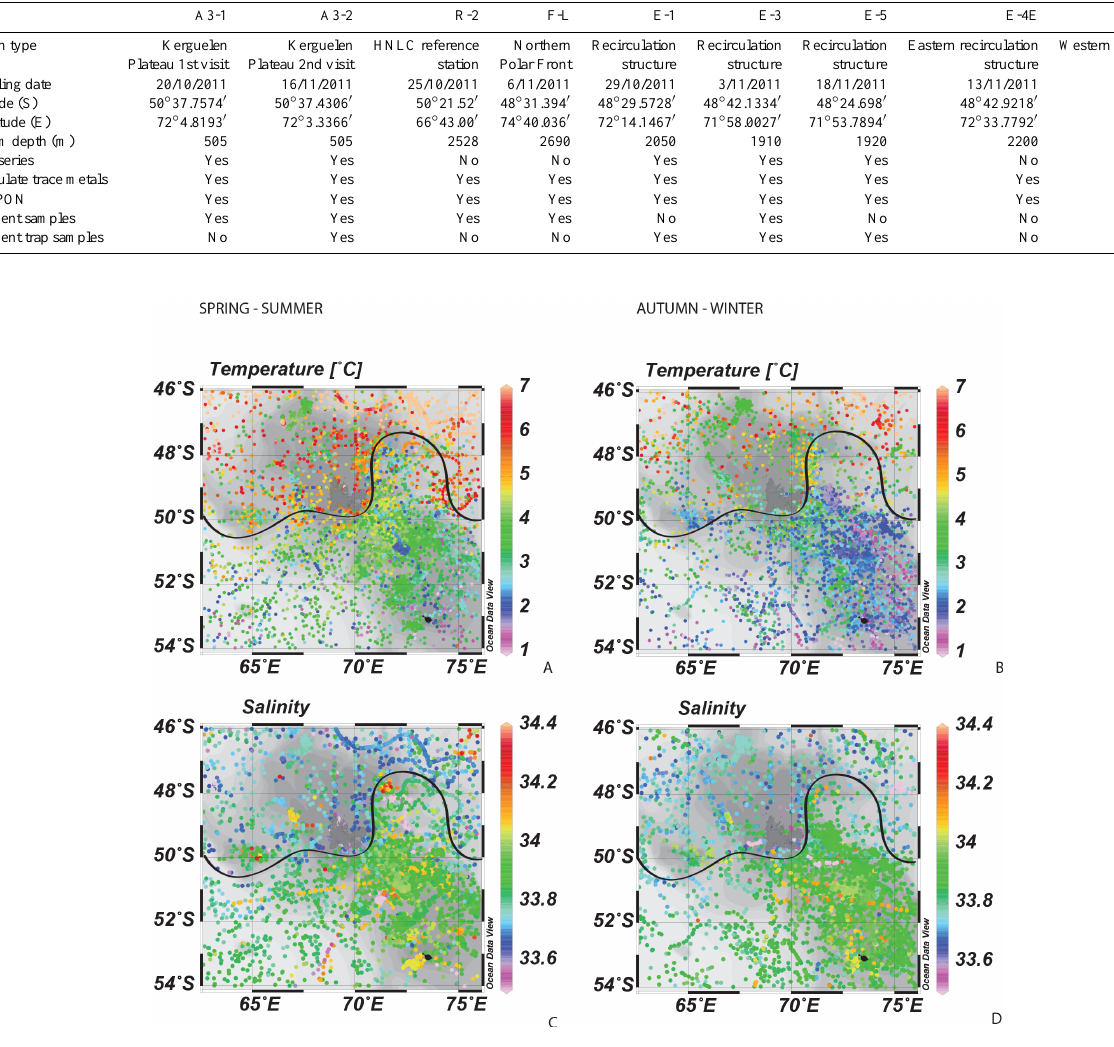
Figure 2. Surface (10m) temperature in spring–summer (a) and autumn–winter (b) as well as surface salinity in spring–summer (c) and autumn–winter (d) within the study area from 1970 until 2013. The PF is identified as a solid black line. Kerguelen and Heard Island are visible in dark grey and black respectively and the Leclaire Rise can be identified as the shallow bathymetry, north of the PF, near the western boundary of the map. Data obtained from the World Ocean Database